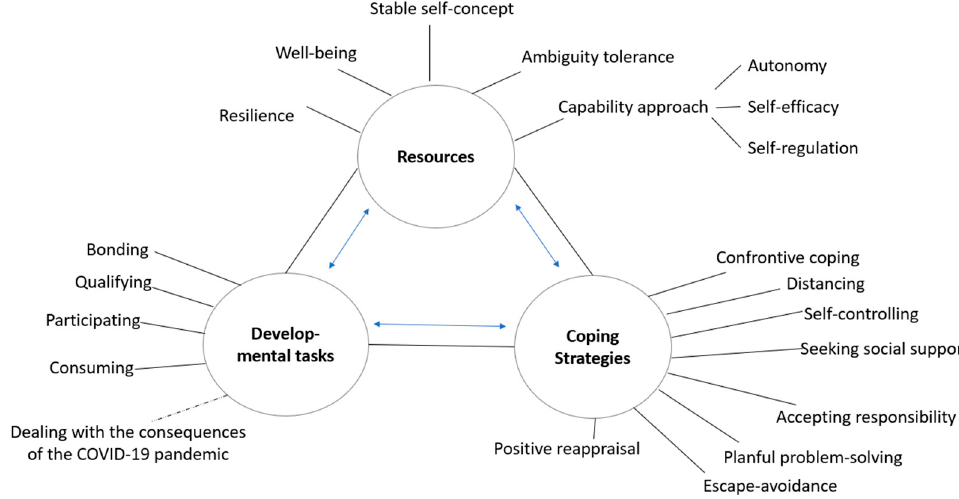
Figure 1. Developed model based on the theoretical framework.